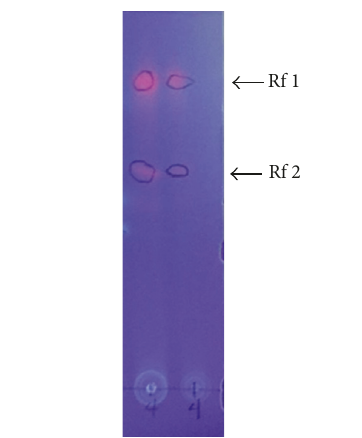
Figure 2: TLC based detection of alkaloids of O. cochenillifera muci- lage extracts visualized under UV at 254